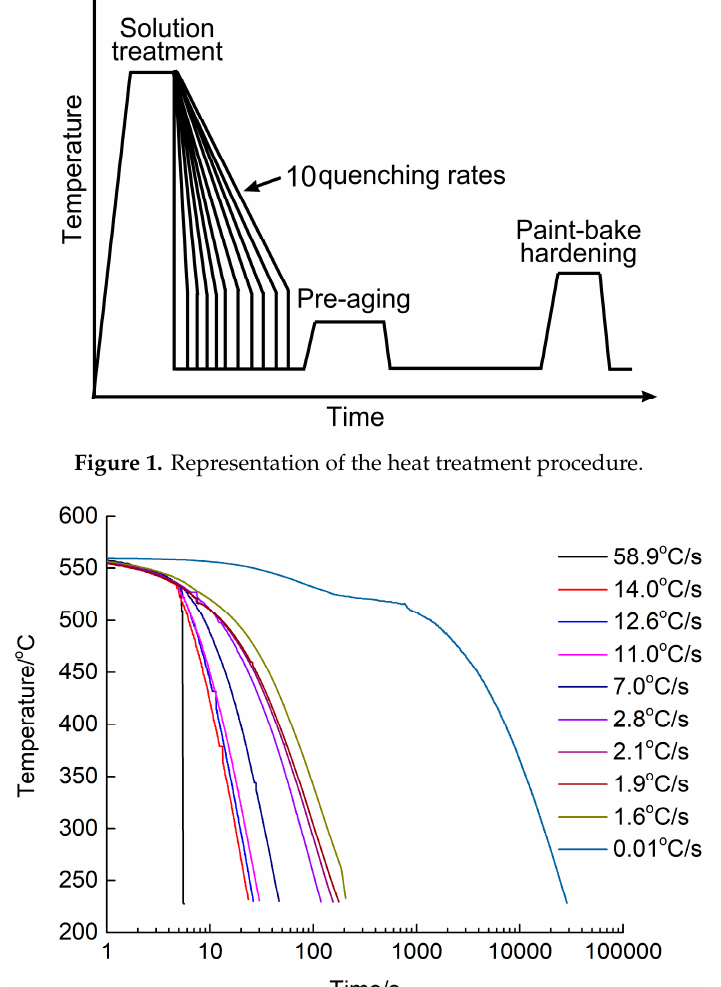
Figure 2. Ten cooling curves of different quenching rates from 58.9 °C/s to 0.01 °C/s.